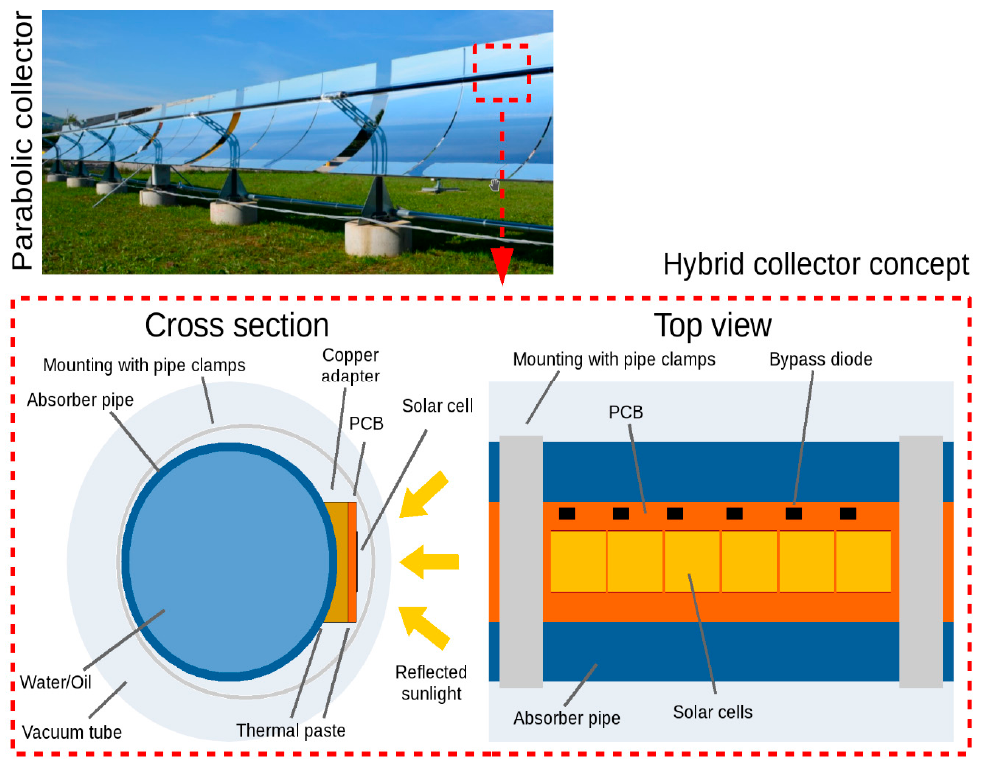
Figure 5. Schematics and principle of the thermo-electric hybrid absorber retrofit concept. The focus point is moved from the center of the tube to the center of the solar cell. This causes most of the irradiation to fall on the solar cell, which in turn dissipates electrical energy and transfers the remaining thermal energy to the heat transfer fluid (HTF) inside the absorber pipe. Since the construction creates a line focus, the solar cells should be packed as close together as possible to achieve the highest possible electrical efficiency.